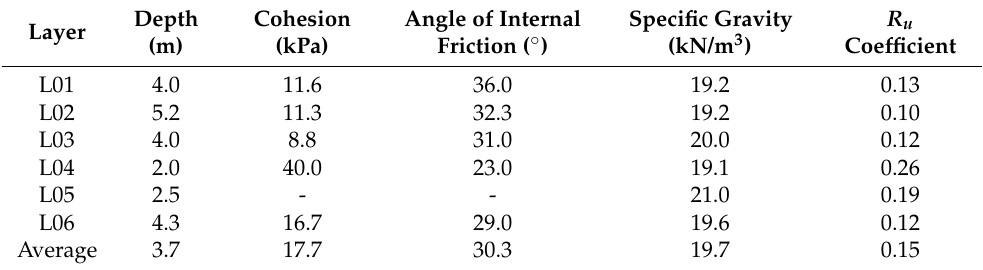
Table 1. Input soil parameters for the simulations of Scoops3D in the Mailuu-Suu catchment (adapted from Li et al. [56]). Layer